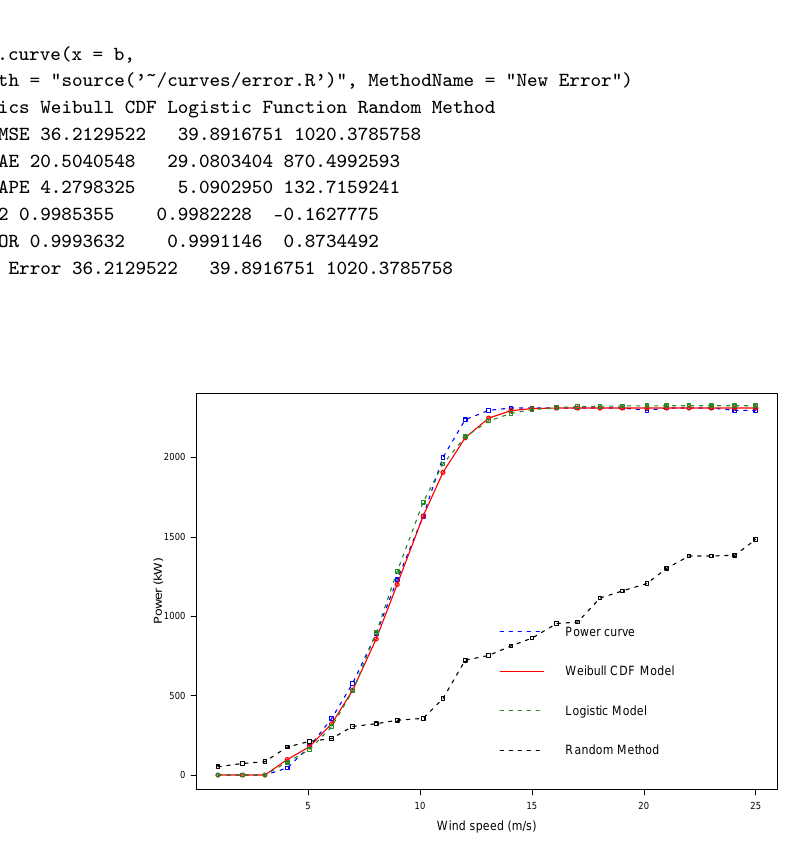
Figure A4. The plot of the WT power curve fitted with the ‘ fitcurve() ’